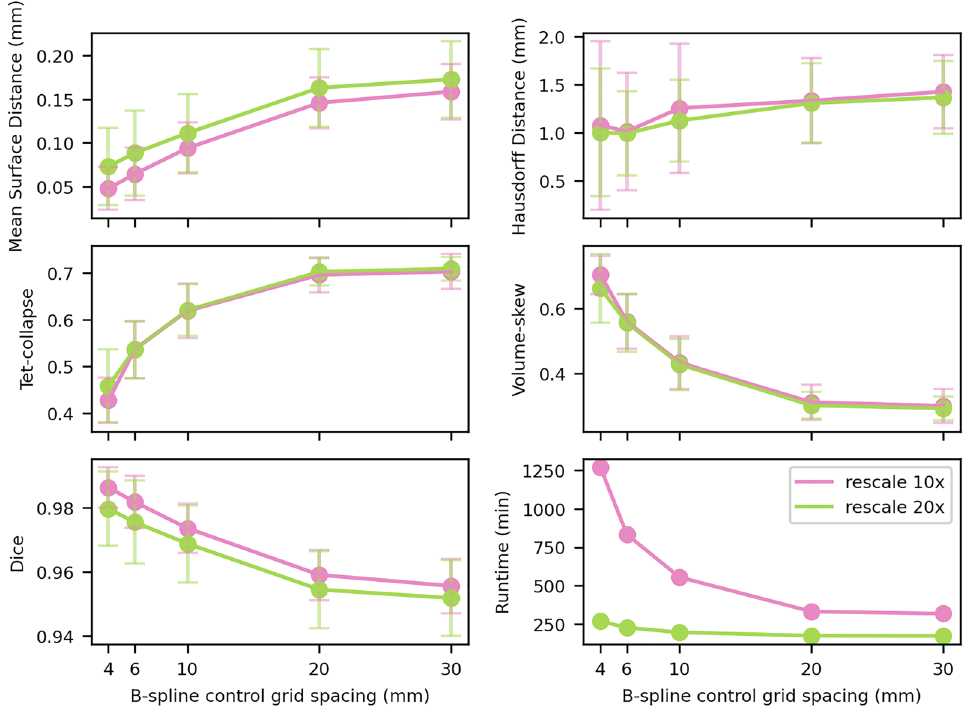
Figure 4. Average image and mesh metrics as well as runtime for the parameter identification studies. Each plot shows a single metric, split up for the two tested rescaling factors. The bars show the standard deviation. Runtimes are given for the canonical bone creation using 16 CPUs in